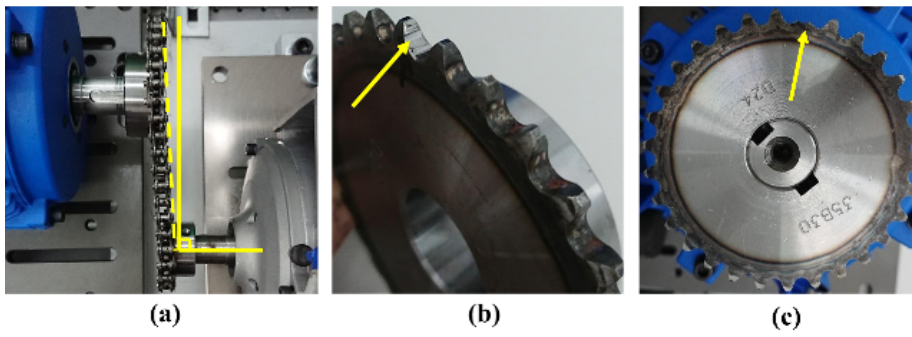
Figure 5. Gear-to-gear faults: ( a ) slightly worn damage at a tooth of the driven gear; ( b ) severely worn damage along a tooth of the driven gear; ( c ) no lubricant at both the driving and driven gear.